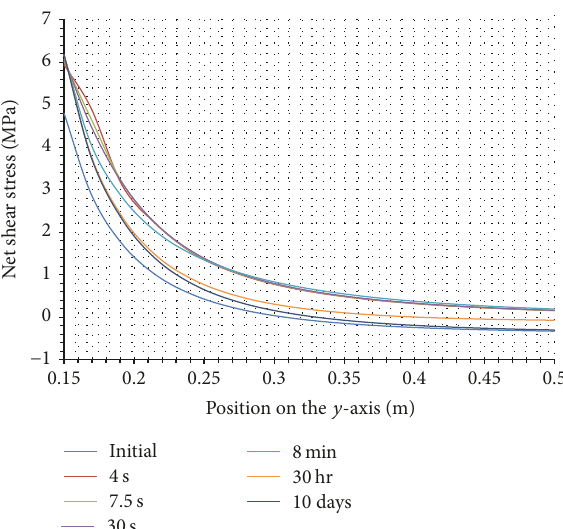
Figure 11: 𝑌 -component of net shear stresses as a function of time in poroelastic medium with 𝜎 𝐻 = 16.8MPa and 𝜎 ℎ = 14 MPa, 𝑃 𝑟 = 11MPa, 𝑃 𝑤 = 9.7 MPa, 𝑘 𝑥 = 0.01 md, 𝑘 𝑦 = 0.01md, and 𝑇 𝑚 = 330 K.